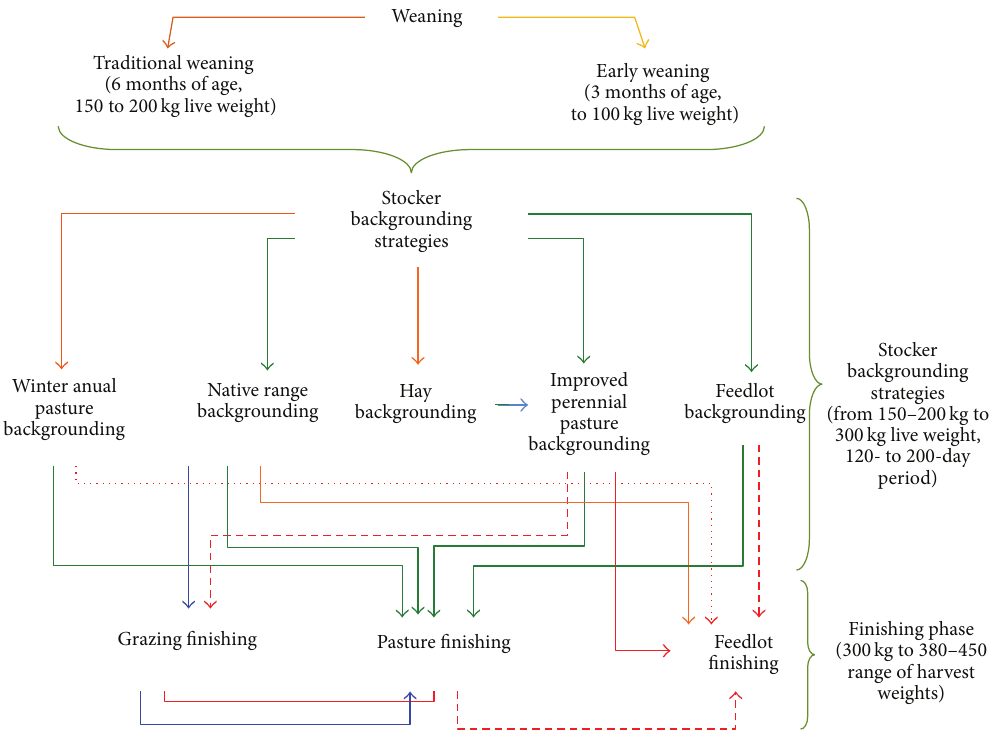
Figure 1: Illustrative platform of main beef production systems in